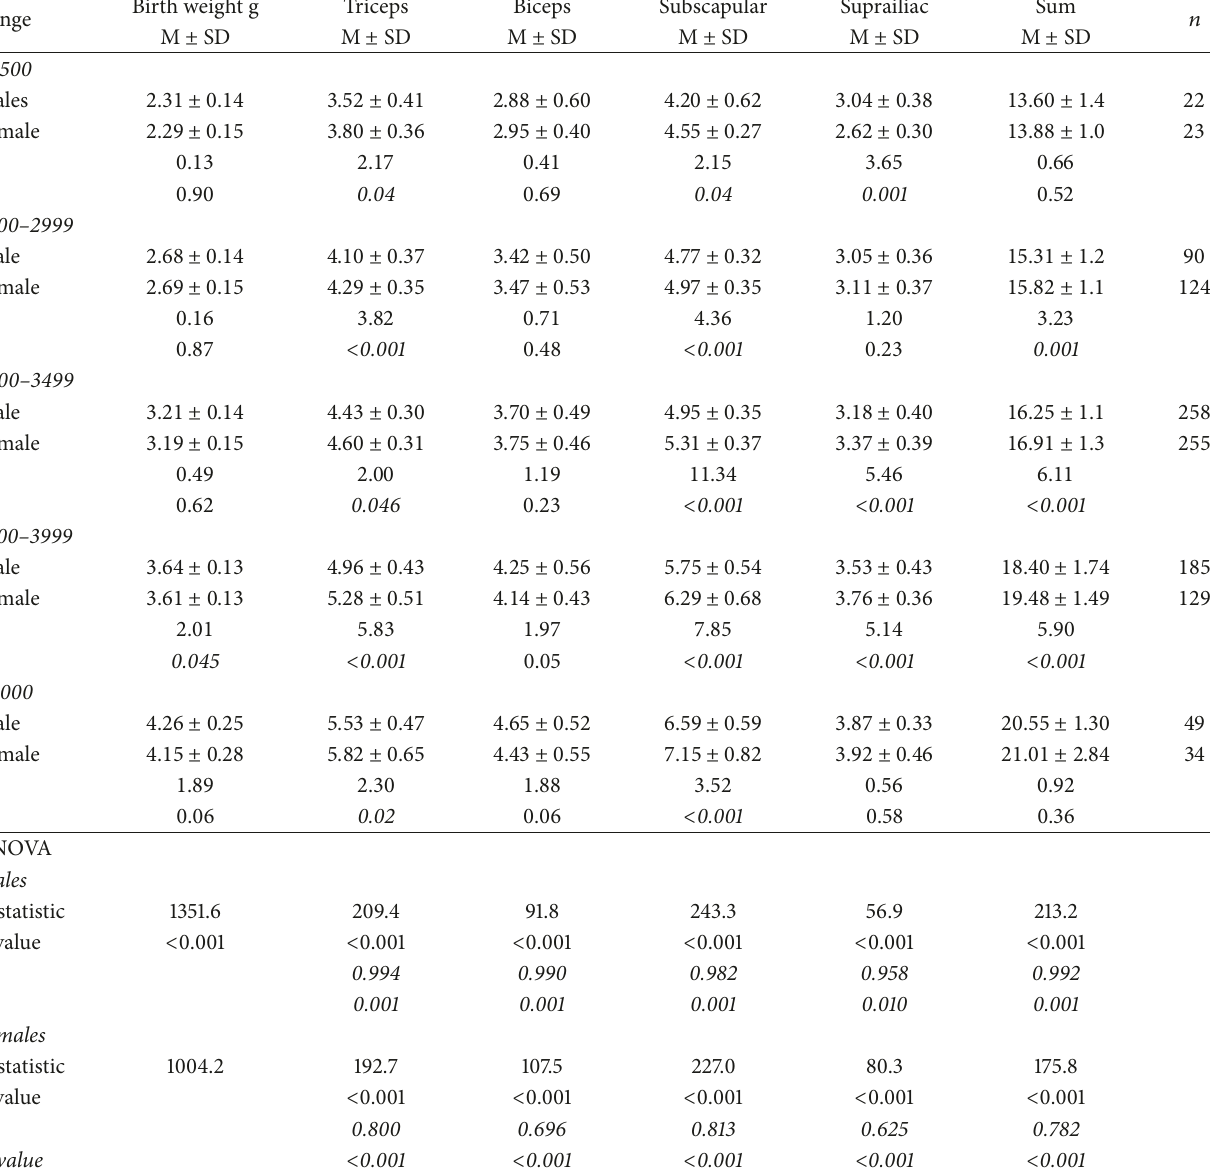
Table 7: Mean skinfold thickness values ± SD in males and females according to birth weight groups.